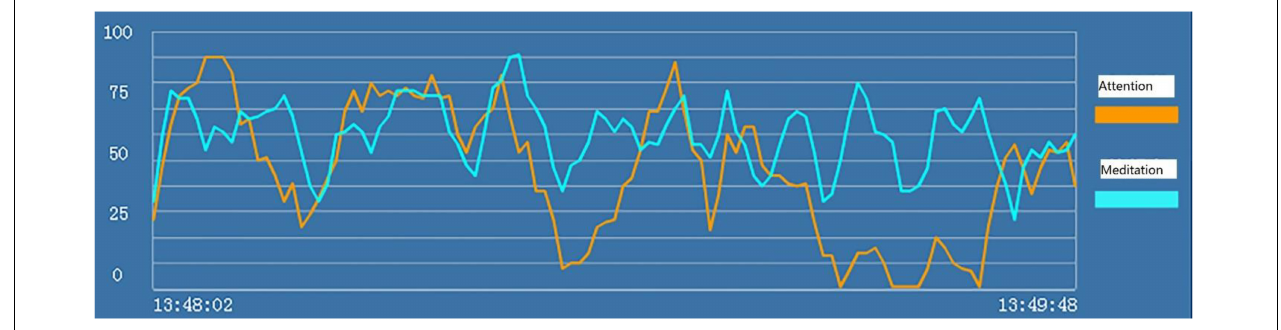
FIGURE 2 | “Attention” (the orange line) and “meditation” (the blue line) signals in the HTP drawing test for subject A3 who did not have state